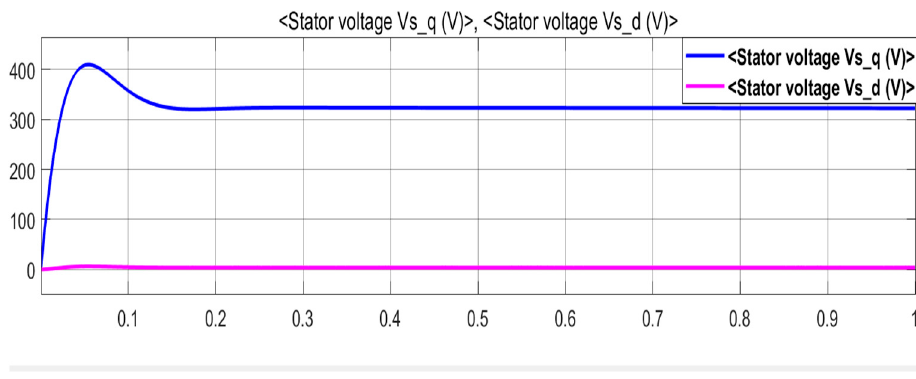
Figure 7. Stator d-q voltages.